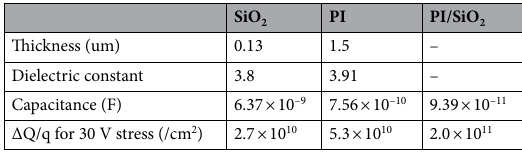
Table 1. MIM capacitance and parameters from C–V measurement.